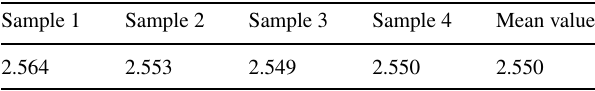
Table 4 Calculated fractal dimensions for Wallace sandstone core